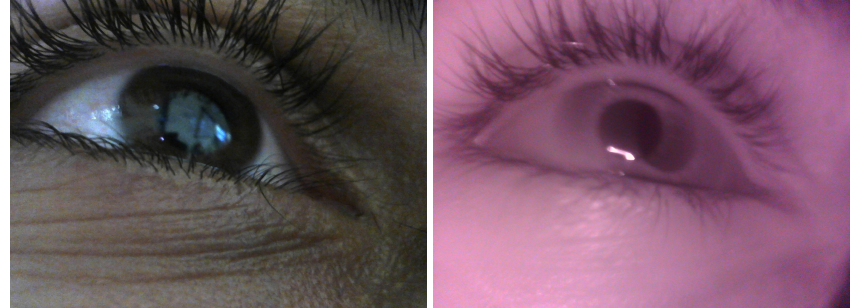
Figure 10. Unsynchronized capture. Left: RGB, right: IR image where the pupil is distorted during a saccade.